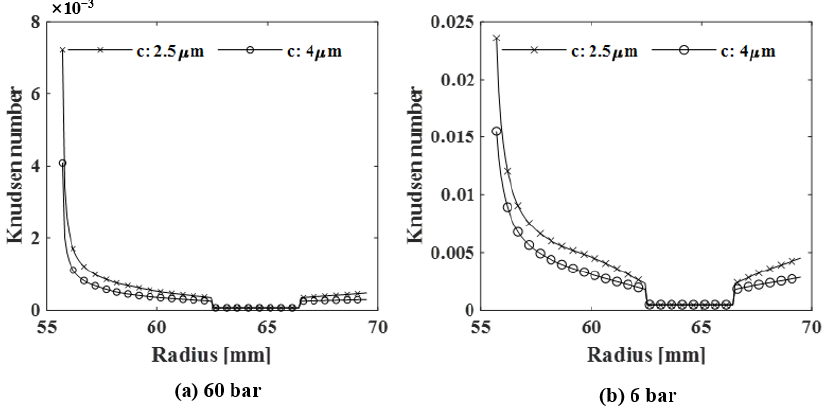
Figure 10. The Reynolds number with different clearances and outer pressures at θ = 0°.